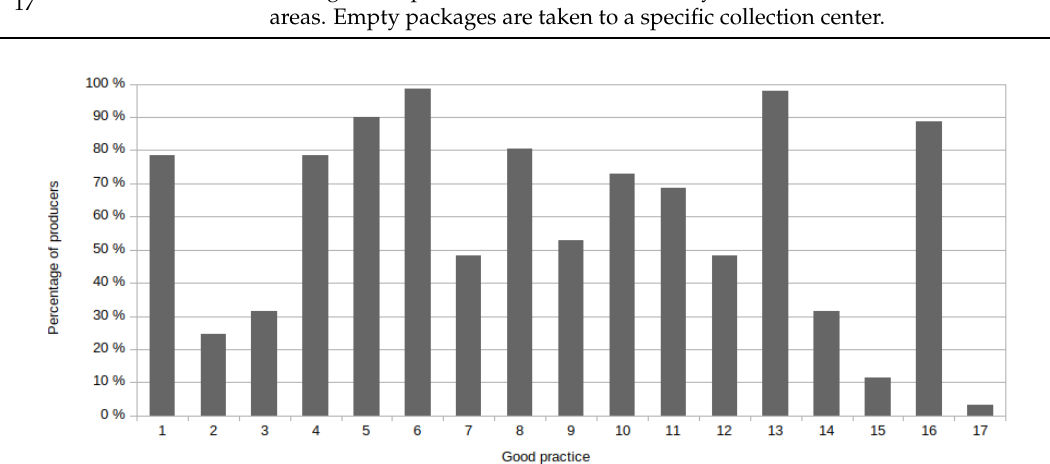
Figure A1. Percentage of dairy producers adopting each